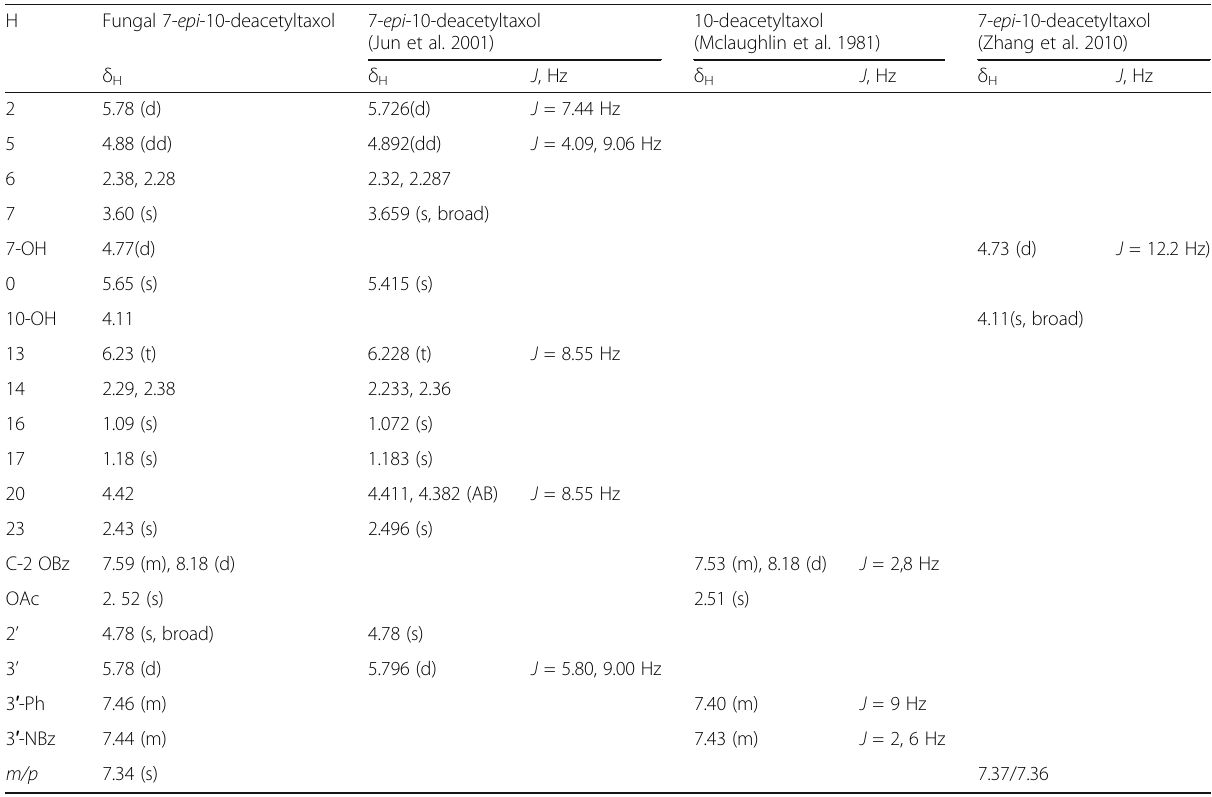
Table 1 Comparison of 1 H NMR data of fungal EDT with previously reported plant-derived 7- epi -10-deacetyltaxol and 10- deacetyltaxol chemical shifts ( δ in ppm) and coupling constants ( J ,